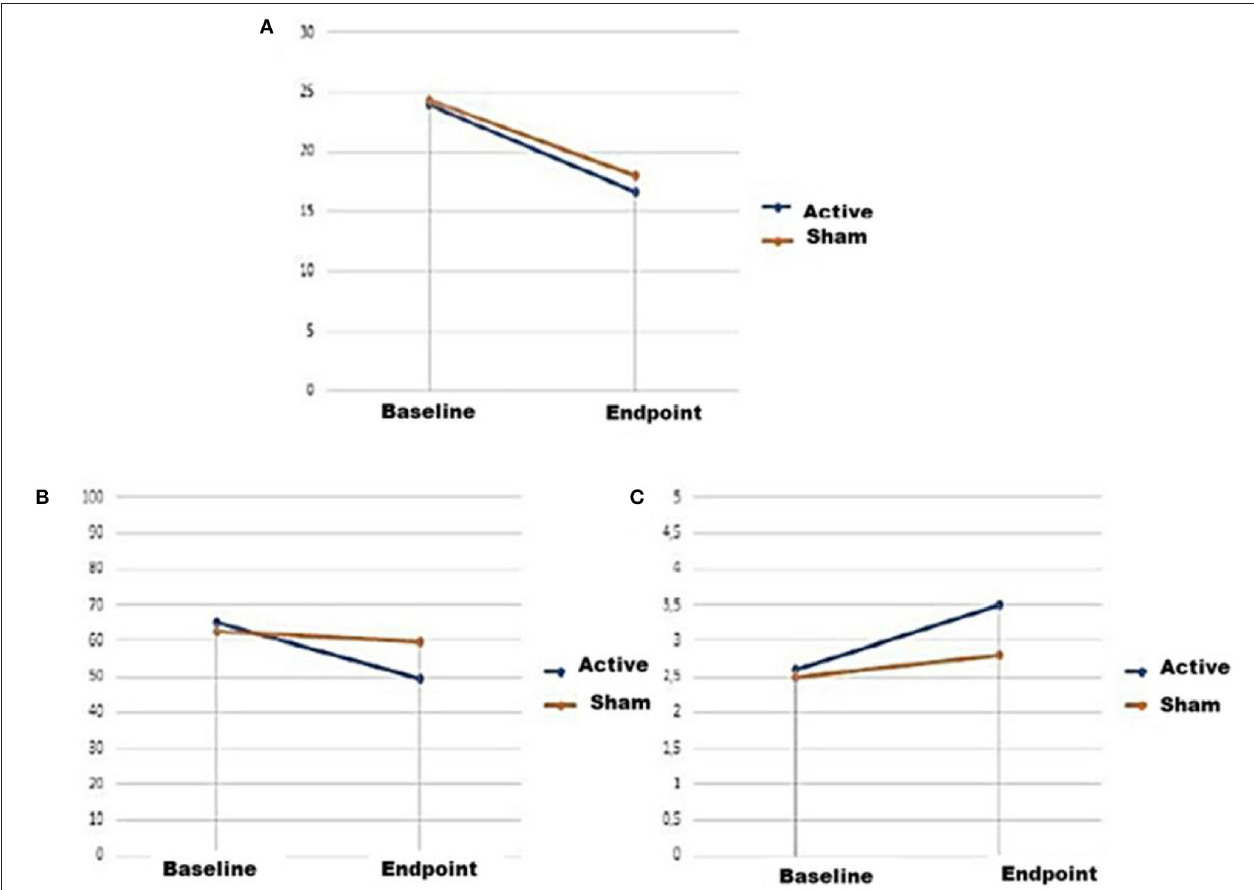
FIGURE 4 | Line graphs representing mean ± mean standard error of the three clinical outcomes at baseline and endpoint of active and sham conditions. (A) Scores on the MIDAS questionnaire, (B) scores on the HIT-6 questionnaire, (C) scores on the FFMQ-BR questionnaire.